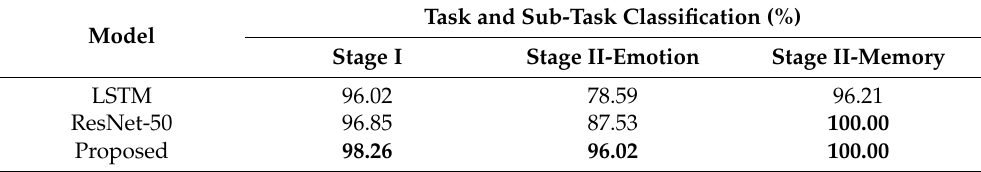
Table 4. Overall accuracy of models for task classification in Stage I, and emotion and memory phase classification experiments in Stage